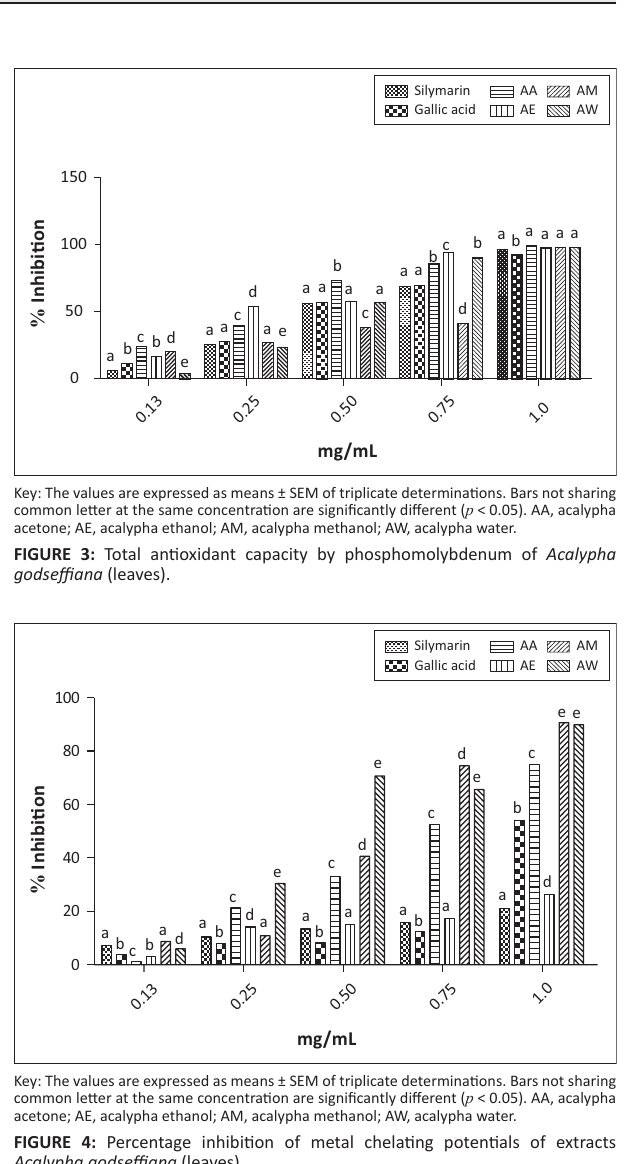
FIGURE 4: Percentage inhibition of metal chelating potentials of extracts Acalypha godseffiana